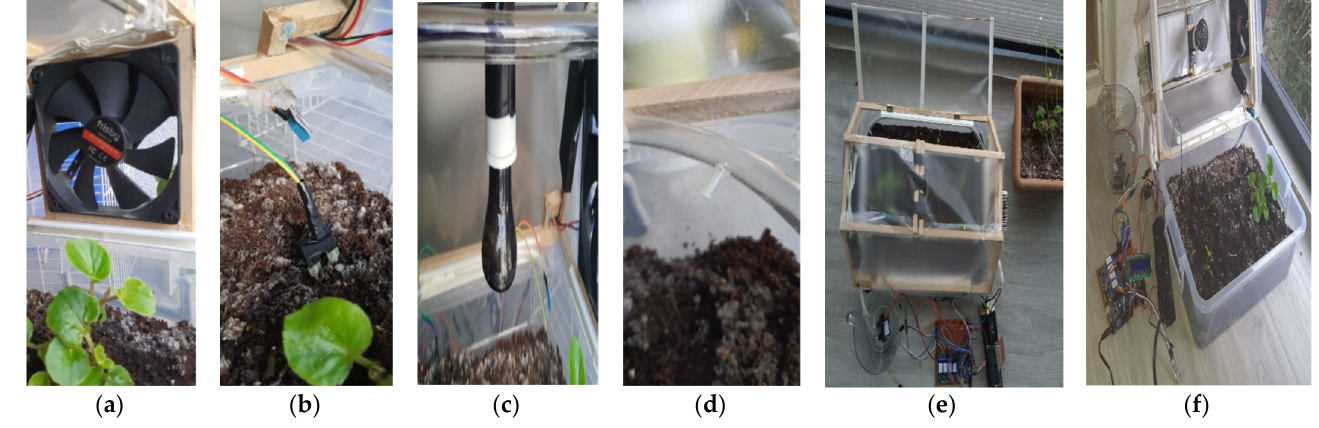
Figure 2. ( a ) Fans, ( b ) soil moisture sensors, ( c ) light and heater, ( d ) irrigation system on prototype ( e ), and ( f ) the view of the smart greenhouse system with all its components and the flower pot. In order to turn the prepared prototype into a smart greenhouse and operate it, the circuit design was also determined. The Arduino Uno microcontroller and the circuit design that we designed accordingly are shown in Figures 2e,f and 3.